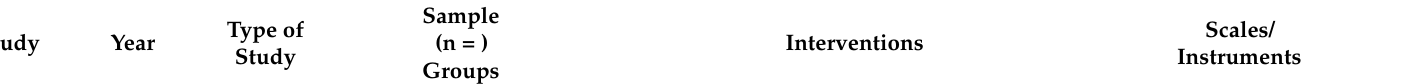
Table 2. Summary of the most relevant results obtained from the